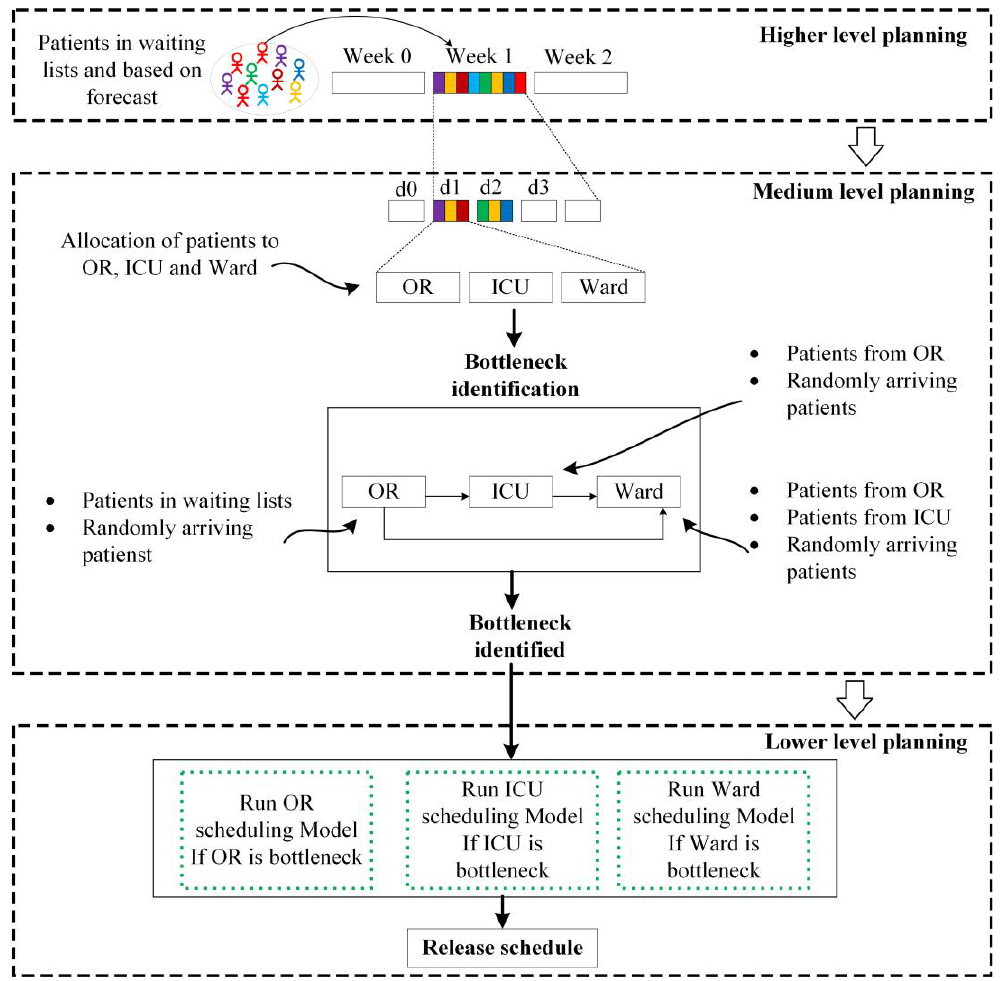
Figure 2. Multi-level planning considered in the current paper.